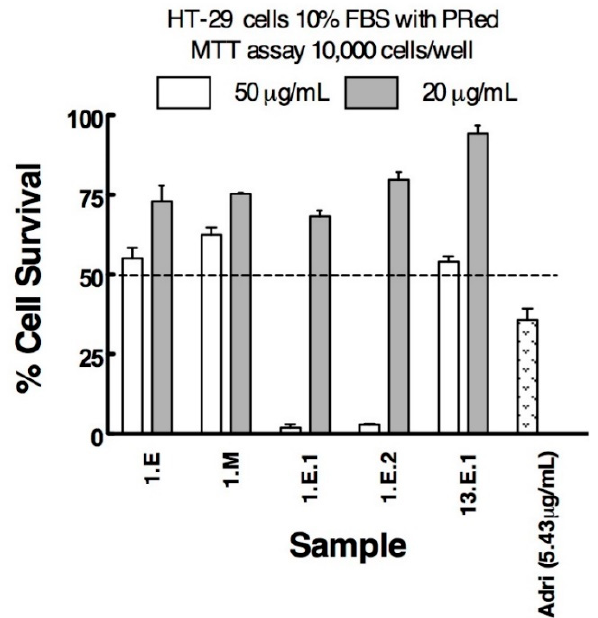
Figure 4. Cell survival of a cytotoxic assay against the HT29 colon cancer cell line of different samples tested at two concentrations (20 µg/mL and 50 µg/mL). Adriamycin at 5.43 µg/mL was used as reference.